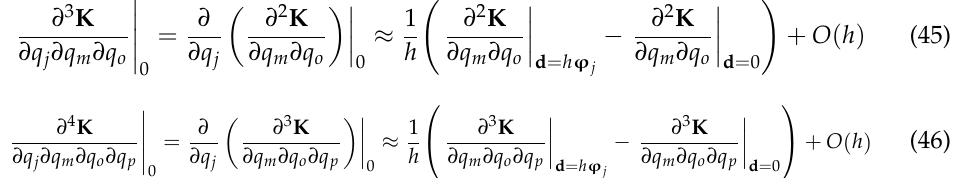
Detailed forward difference equations of the third- and fourth-order derivatives of